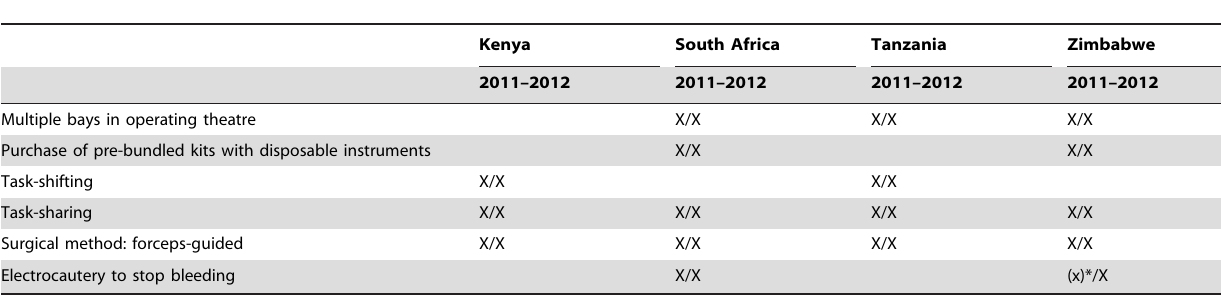
*Indicates partial adoption of efficiency element. doi:10.1371/journal.pone.0082911.t003 PLOS ONE |